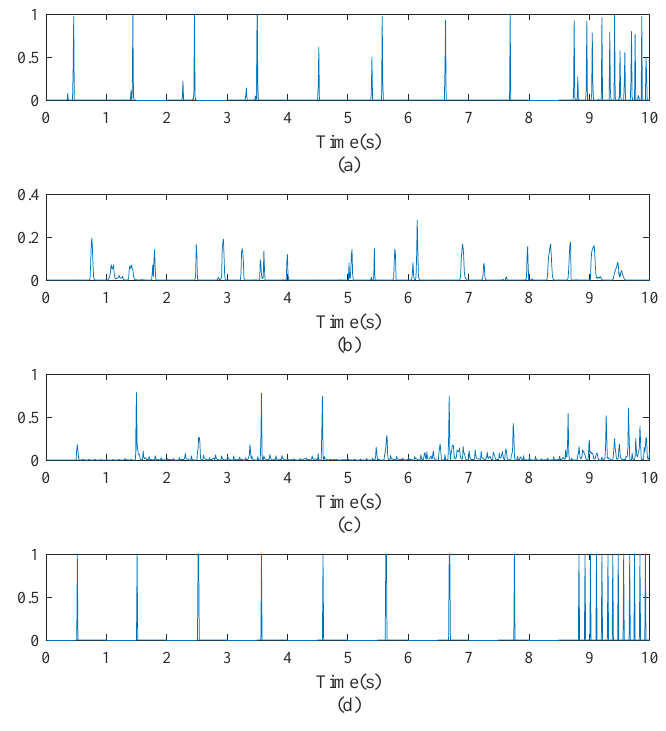
Figure 6. Results of onset detection: ( a – c ) the output of CNN, DNN, and RNN, respectively; ( d ) the corresponding ground truth.